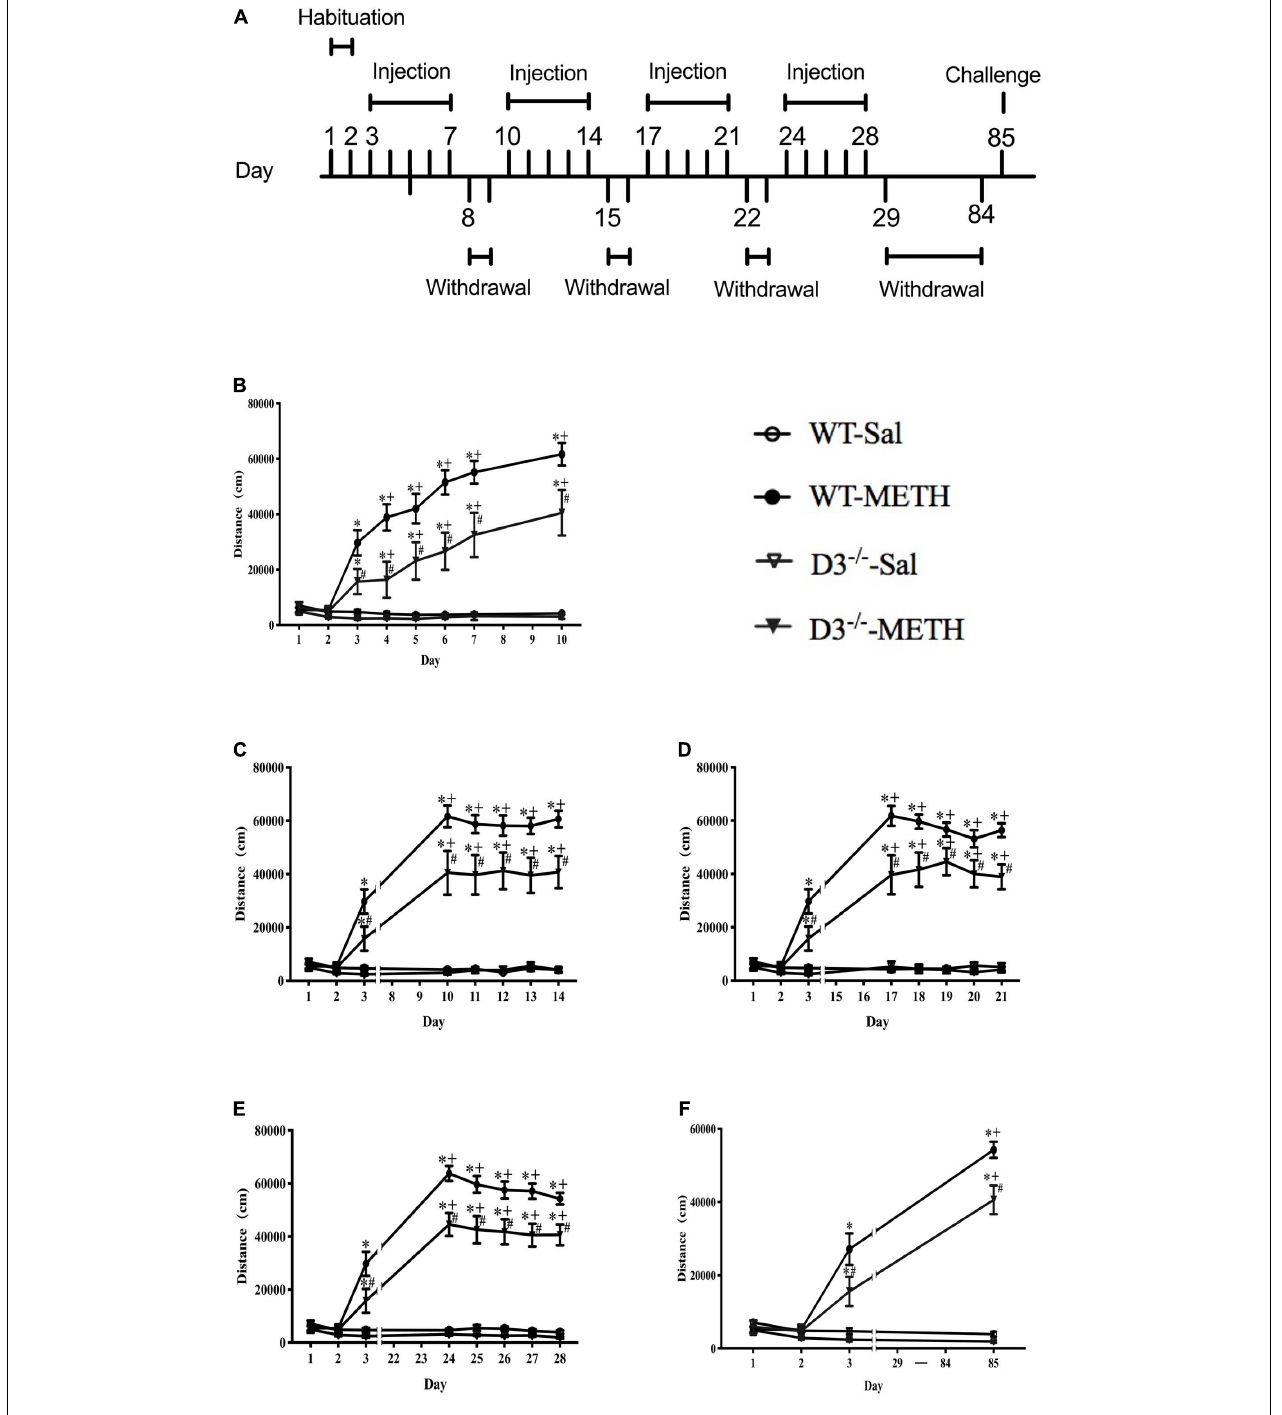
FIGURE 1 | Knockout of dopamine D3 receptor gene attenuated METH-induced long-term behavioral sensitization. (A) Administration schedules. Days 1–2: mice were injected i.p. in volumes of 10 ml/kg once daily with saline and their horizontal locomotor activities were measured for 60 min after the injections to habituate to the open field and drug treatment. Days 3–7, days 10–14, days 17–21, days 24–28, and day 85: for the 2 mg/kg METH and saline groups, mice were given once-daily injections of either METH or saline, respectively, and their horizontal locomotor activities were determined for 60 min after the injections. Days 8–9, days 15–16, days 22–23, and days 29–84: mice were left undisturbed. (B–F) The locomotor activities of mice after i.p. injection of 2 mg/kg METH or saline on days 1–10 (B) , days 11–14 (C) , days 17–21 (D) , days 24–28 (E) , and day 85 (F) . Values are presented as mean ± SEM. ∗ P < 0.05 compared with the same genotype in saline group; # P < 0.05 compared with same-dose WT mice; + P < 0.05 compared with day 3. WT, wild